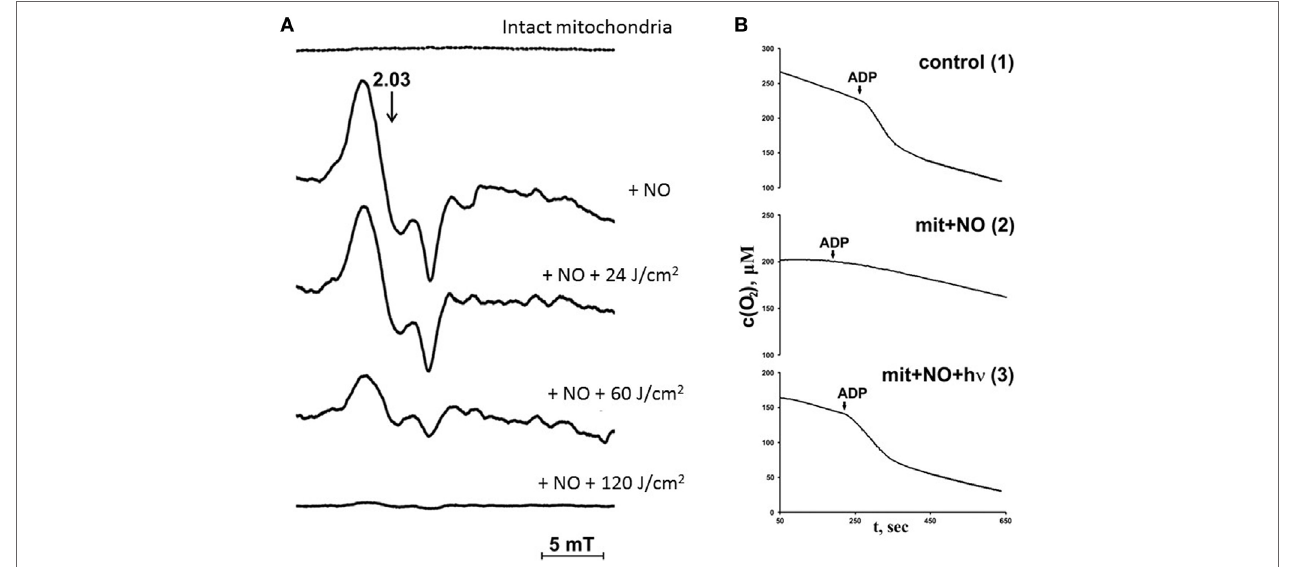
FigURe 5 | Effects of nitric oxide (NO) and laser radiation on rat liver mitochondria respiration under hypoxic conditions [reproduced with the permission of Springer Publisher from Buravlev et al. (24)]. (A) Effects of He–Cd laser (442 nm) irradiation and NO on mitochondria nitrosyl complex electron spin resonance signal. Top line— control mitochondria (1.0 mg protein/ml), next line down mitochondria + NO (3 mM); next lines down—mitochondria + NO + laser irradiation (24, 60, and 120 J/cm 2 , respectively). The hypoxic conditions were produced by incubation of mitochondria during 10 min with an excess of 0.8 mM ADP and 10 mM sodium succinate in storage buffer [the content of the storage buffer is in the legend to panel (B) ], in air isolated cell. (B) Kinetic curves of oxygen uptake in mitochondria (1.0 mg protein/ml). 1—Intact mitochondria (control); 2—mitochondria subjected to 3 mM NO; and 3—mitochondria subjected to 3 mM NO and laser irradiation ( λ = 442 nm, 30 J/cm 2 ).